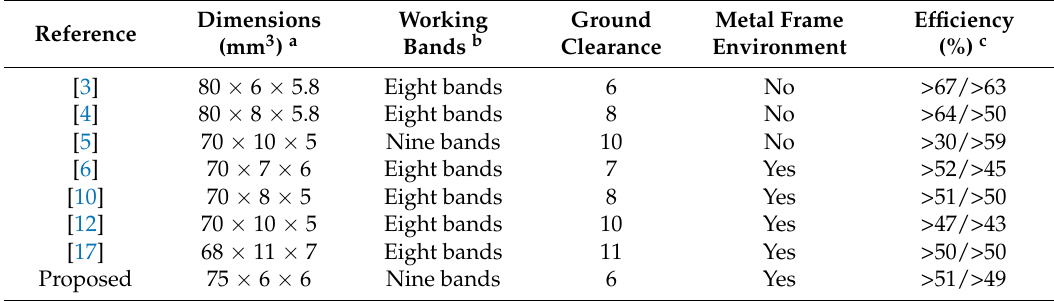
Table 1. Performance of some mobile